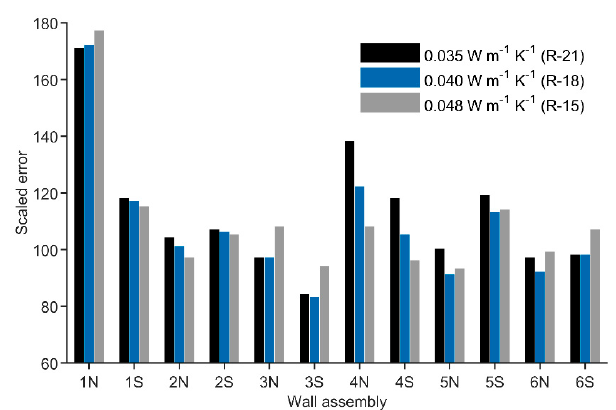
Figure 22. Scaled error for various fiberglass insulation values.